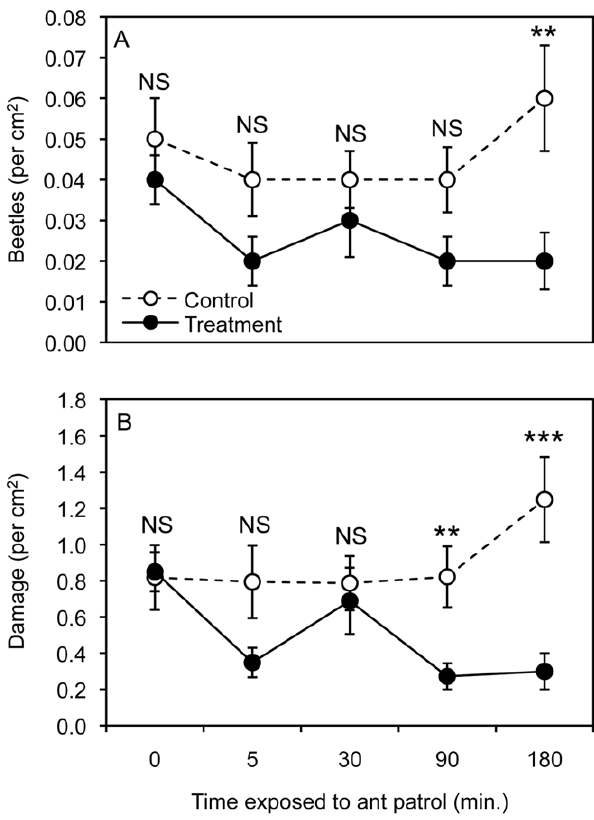
Figure 2. The effect of ant-treatment exposure-length on beetle choice and herbivory. Experiment 6 treatment means ( 6 SE) for the number of beetles per cm 2 (A) and damage marks per cm 2 (B) on control leaves and leaves exposed to A. instabilis patrolling for 0-, 5-, 30-, 90-, and 180-min. prior to choice test. Statistical differences between ant and control treatment means are represented as: NS= P . 0.05, *= P , 0.05, **= P , 0.01, ***= P , 0.001.